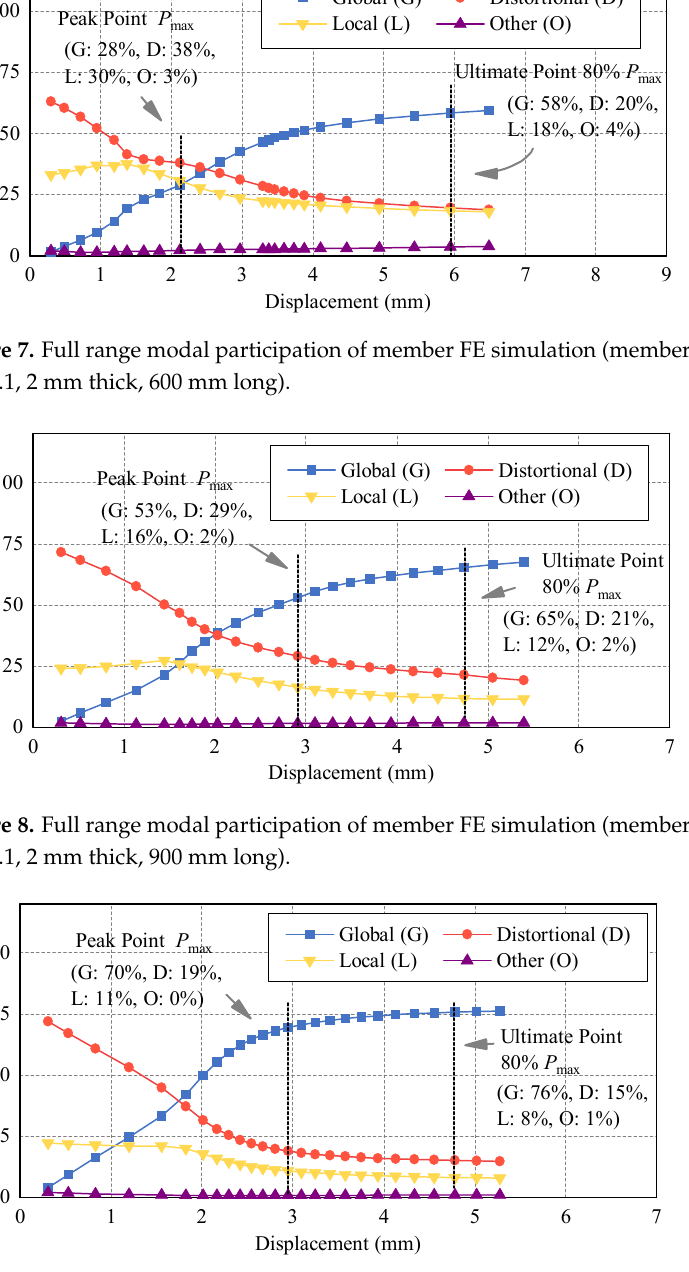
Figure 9. Full range modal participation of member FE simulation (member cross-section parameter is No.1, 2 mm thick, 1200 mm long).